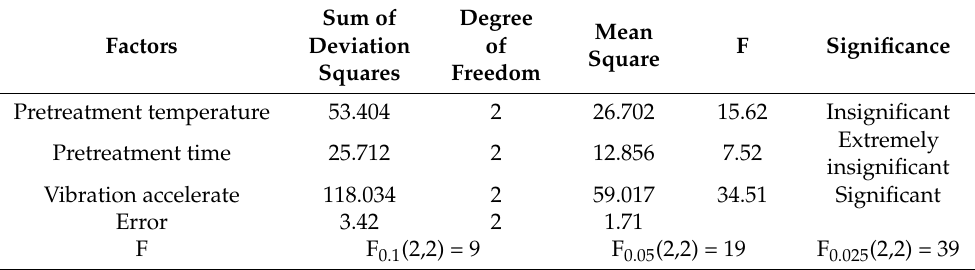
Table 4. Analysis of variance results for interlaminar shear strength of